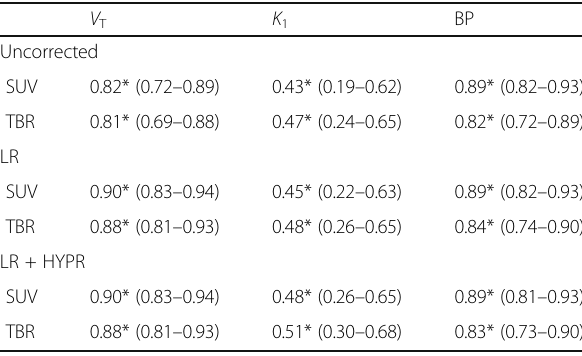
Table 4 Correlation (Spearman, with 95% confidence intervals) between kinetic parameter estimates and simplified